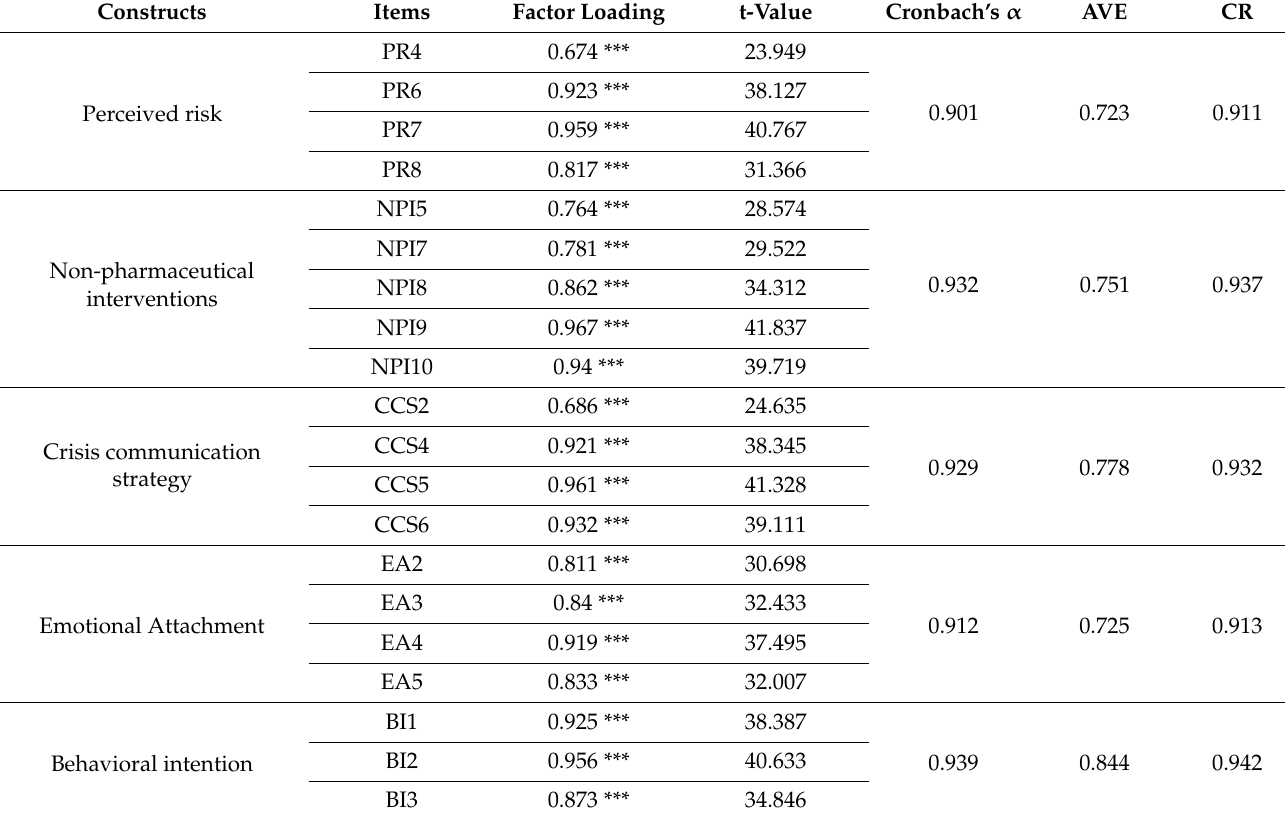
Table 3. Analysis of Reliability and Convergent Validity.